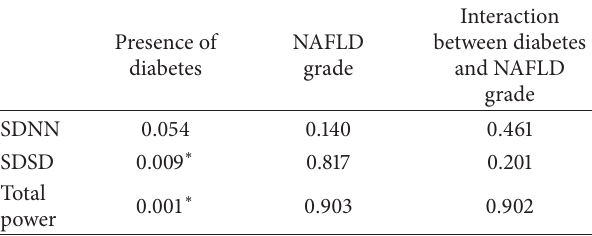
Table 4: Two-way ANOVA for determination of main effect of diabetic status, NAFLD grade, and their